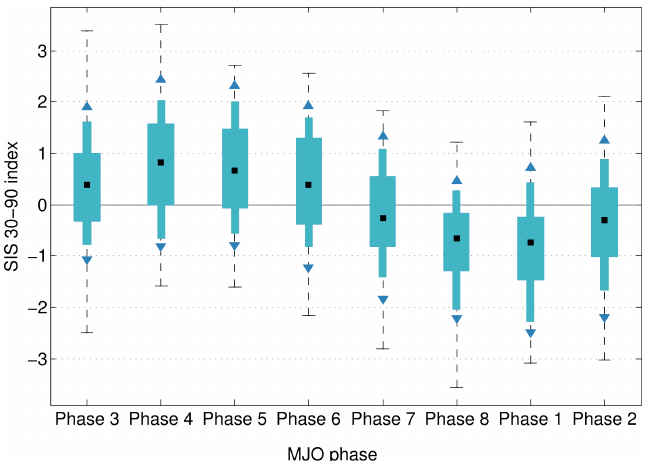
Figure 4. Boxplot of the SIS index values for each MJO phase achieved within an MJO event. The wide box indicates the lower and upper quartiles, the thin box indicates the 10th and 90th percentiles, the triangles indicate the 5th and 95th percentiles, the black square the median and the whiskers the extreme